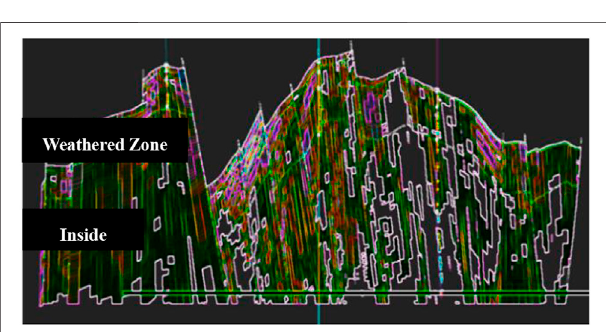
FIGURE 3 | Geological model of fractured reservoir in buried hill. Experiments on testing stress sensitivity of the fracture – matrix system.